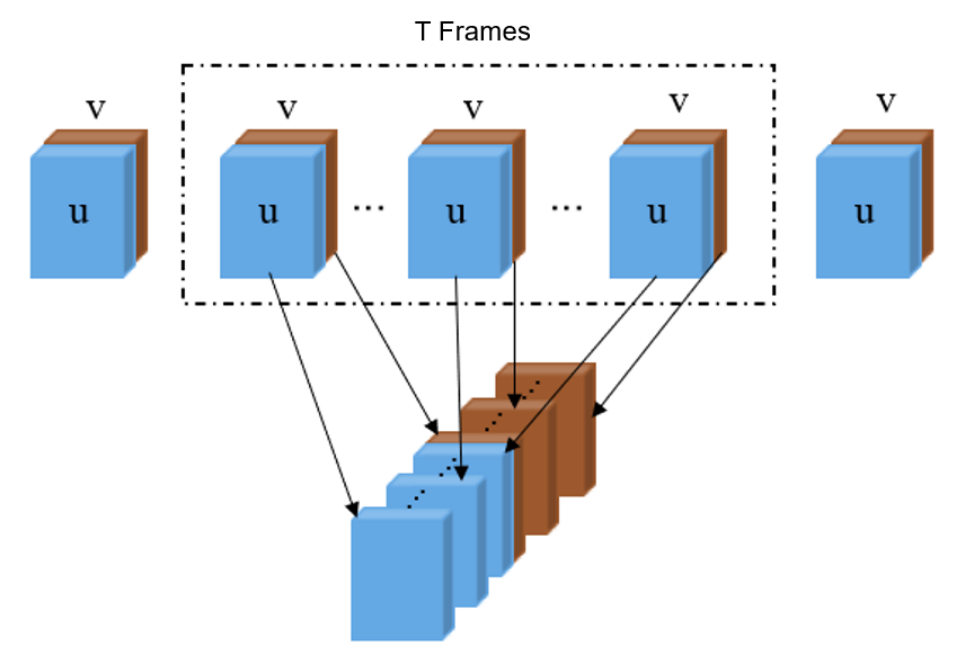
Figure 3. Illustration of stacking optical flow sequences into multi-channel